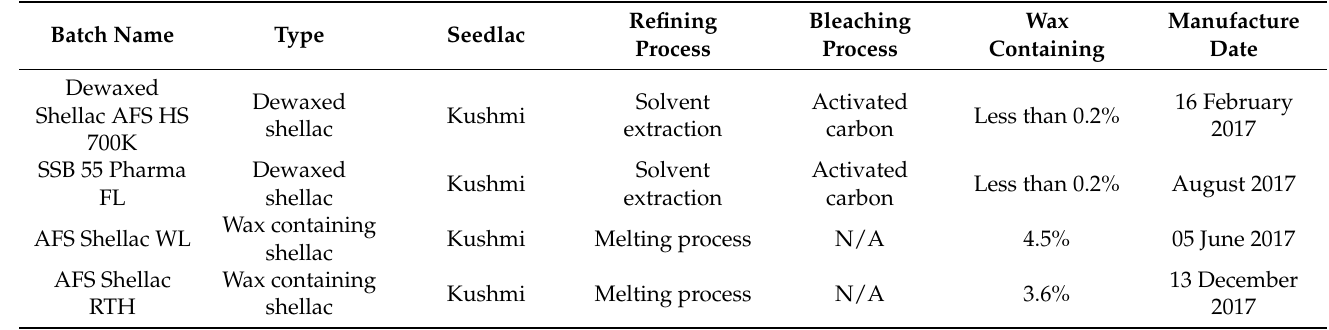
Table 1. Shellac materials used in this